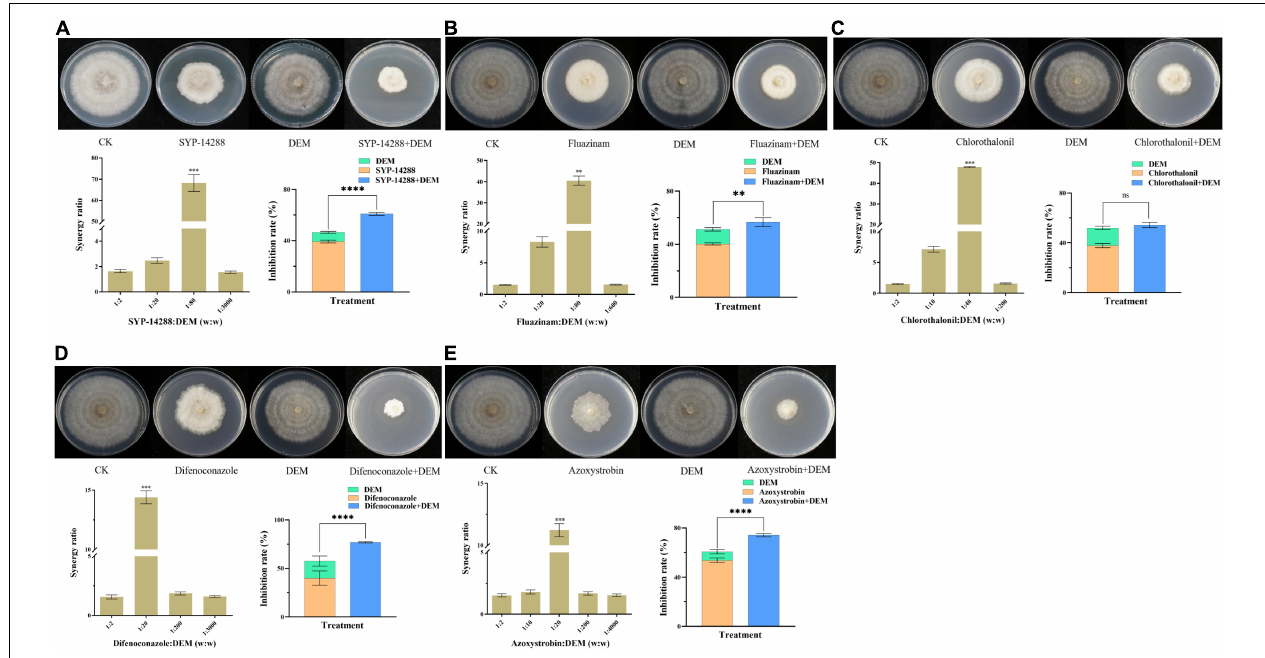
FIGURE 4 | Growth inhibition of Rhizoctonia solani X19-7 by fungicides and their combination with diethyl maleate (DEM). X19-7 was cultured on potato dextrose agar (PDA). Treatments included SYP-14288 (A) , fluazinam (B) , chlorothalonil (C) , difenoconazole (D) , and azoxystrobin (E) amended in PDA. Fungicide-free PDA was used for control. Data were presented as mean ± SD, and the same strain followed by different letters was significantly different according to Fisher’s least significant difference (LSD) test (significance level α = 0.05). Significant differences from mean values of DEM treatment are indicated by asterisks: ∗∗ when p < 0.01, ***when p < 0.005, ∗∗∗∗ when p < 0.001, and ns when there was no